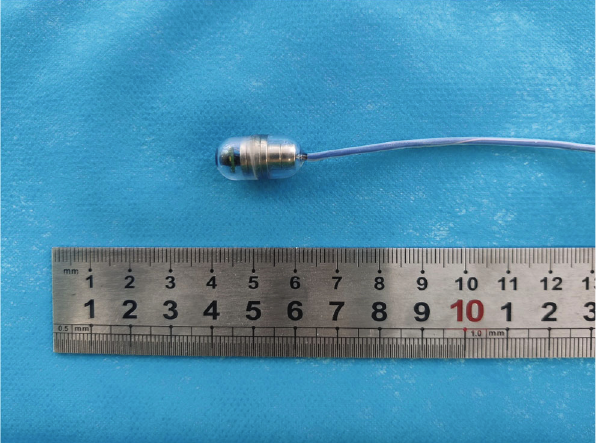
Figure 1: The capsule endoscope and transmission